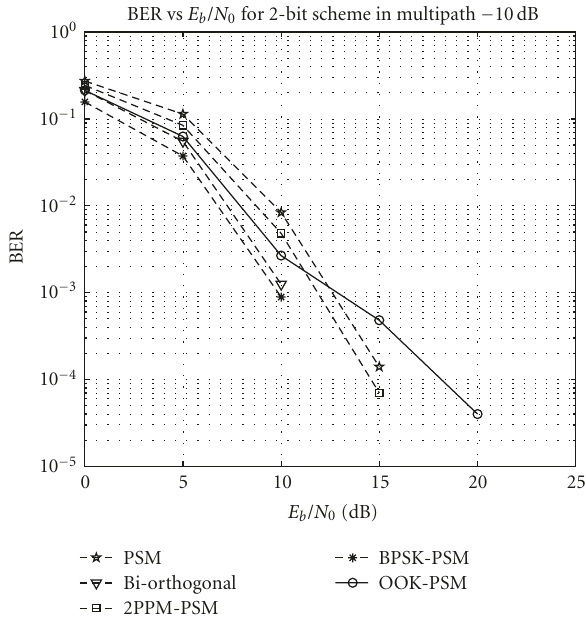
Figure 10: Performance of various modulation schemes for 2-bit symbols transmission in a multipath environments. The receiver assumes a RAKE-combination by considering all paths within − 10 dB of the strongest path. The schemes uses orthogonal pulses based on